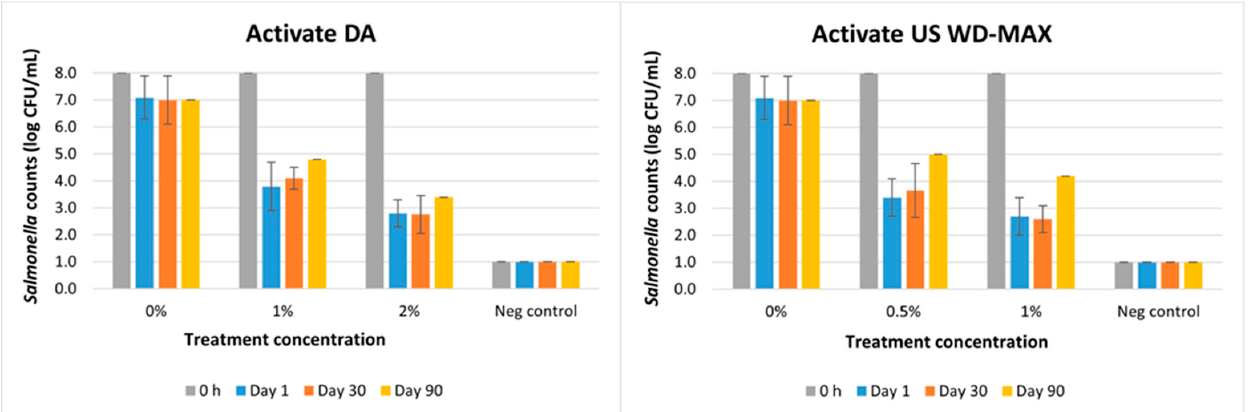
Figure 5. Mean logarithmic counts of Salmonella in pet food kibble treatments with inclusion of or- ganic acid mixtures Activate DA at 1% and 2% and Activate US WD-MAX at 0.5% and 1% concen- trations as coating, in comparison with untreated (0% organic acid) to investigate residual effect of treatments over 1, 30 and 90 days after repeated exposure to Salmonella . A negative control consisted of canola oil-coated kibble (no organic acid, no inoculation). Limit of detection is 1 log CFU/mL for this